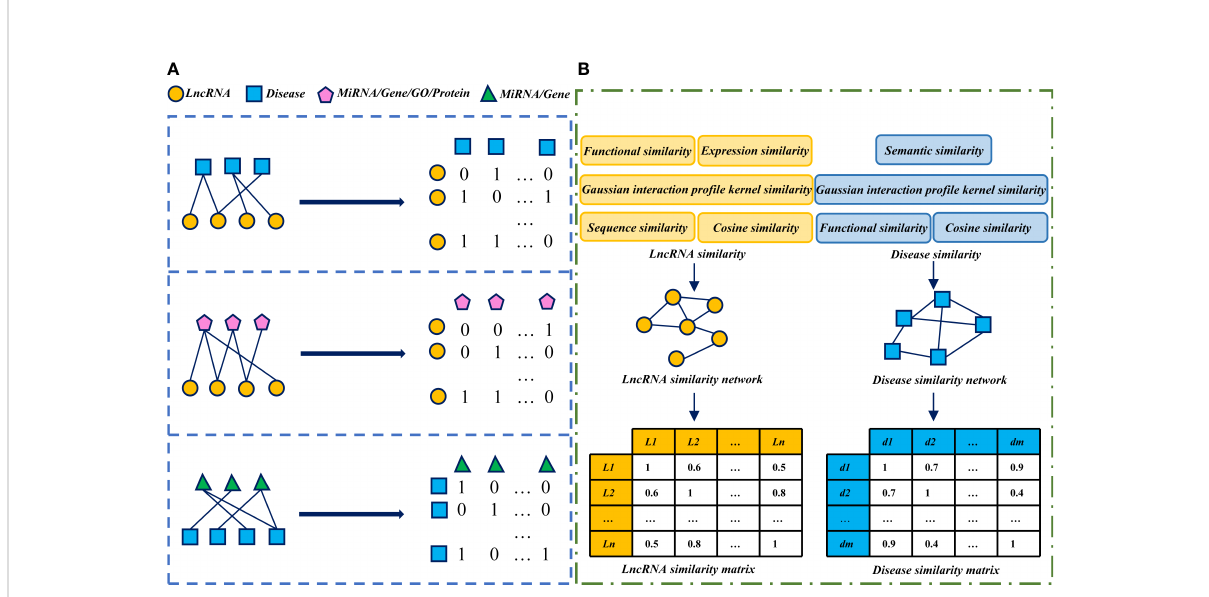
FIGURE 1 The process of network and matrix construction of association and similarity: (A) Construct association network and matrix based on known association data obtained from the database. In the construction of the association matrix. If a data pair is associated, the matrix element sets to 1, otherwise, 0. (B) The similarity network and matrix of LncRNA/disease were constructed by calculating the similarity score of